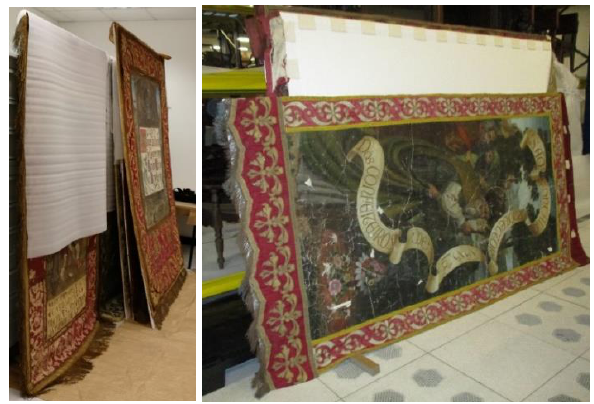
Figure 20 - Some of the banners mounted onto the rigid Tycore ® boards, ready to be fixed to the metallic grids.